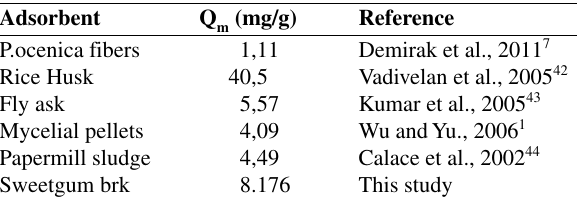
Table 6. Comparison of adsorption capacity for 2,4-DCP between sweetgum bark and other various adsorbents reported in the litera- ture.